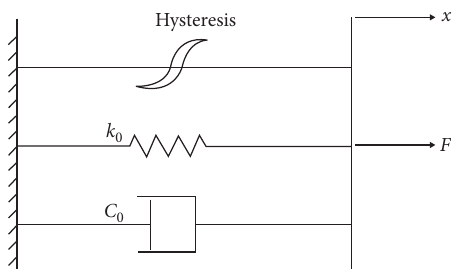
Figure 8: Hyperbolic tangent